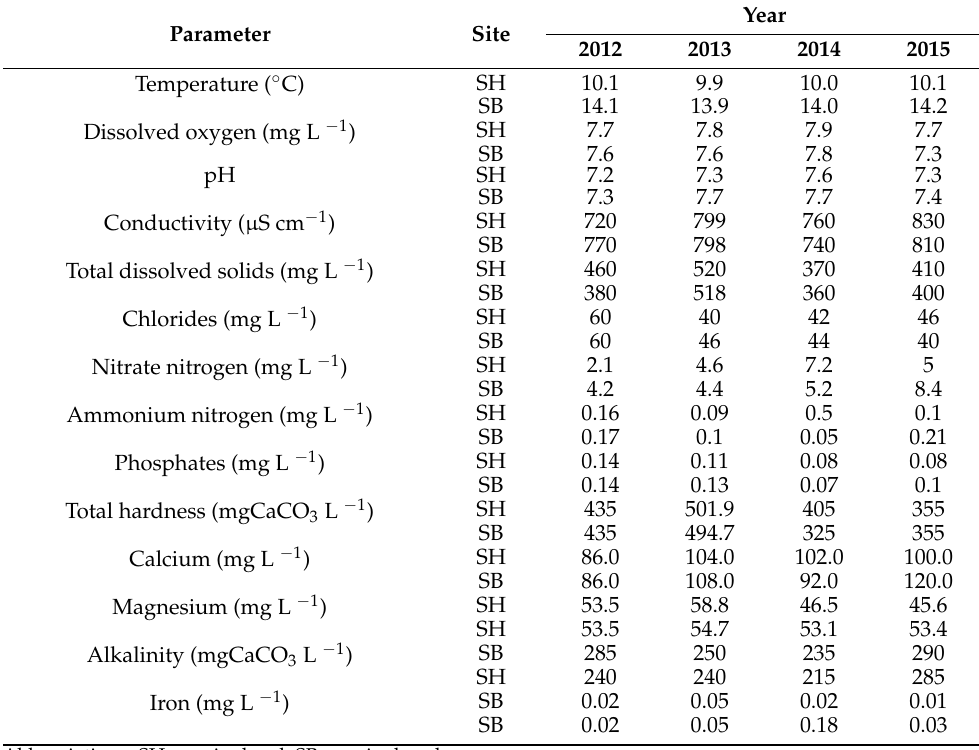
Table 2. Water parameters of the sampling sites in the spring